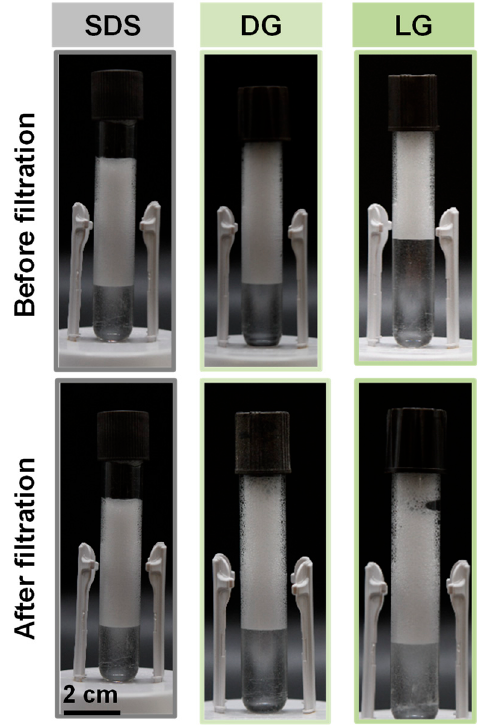
Figure 6. Pictures of the foams produced from the surfactants solution (SDS, DG, and LG) before and after filtration to remove the spores, showing a similar foamability and foam stability around 5 min after producing the foam. The scale bar represents 2 cm for all the pictures.